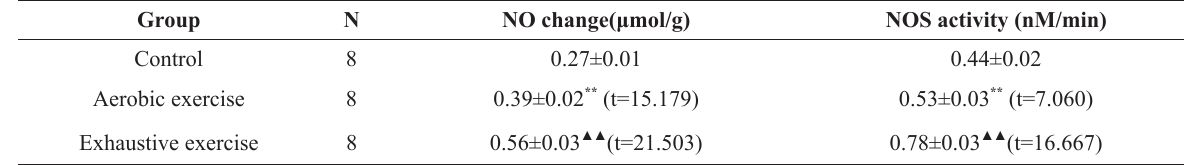
Changes in NO concentration and NOS activity in brain tissue of each group (Mean ± standard deviation). Group